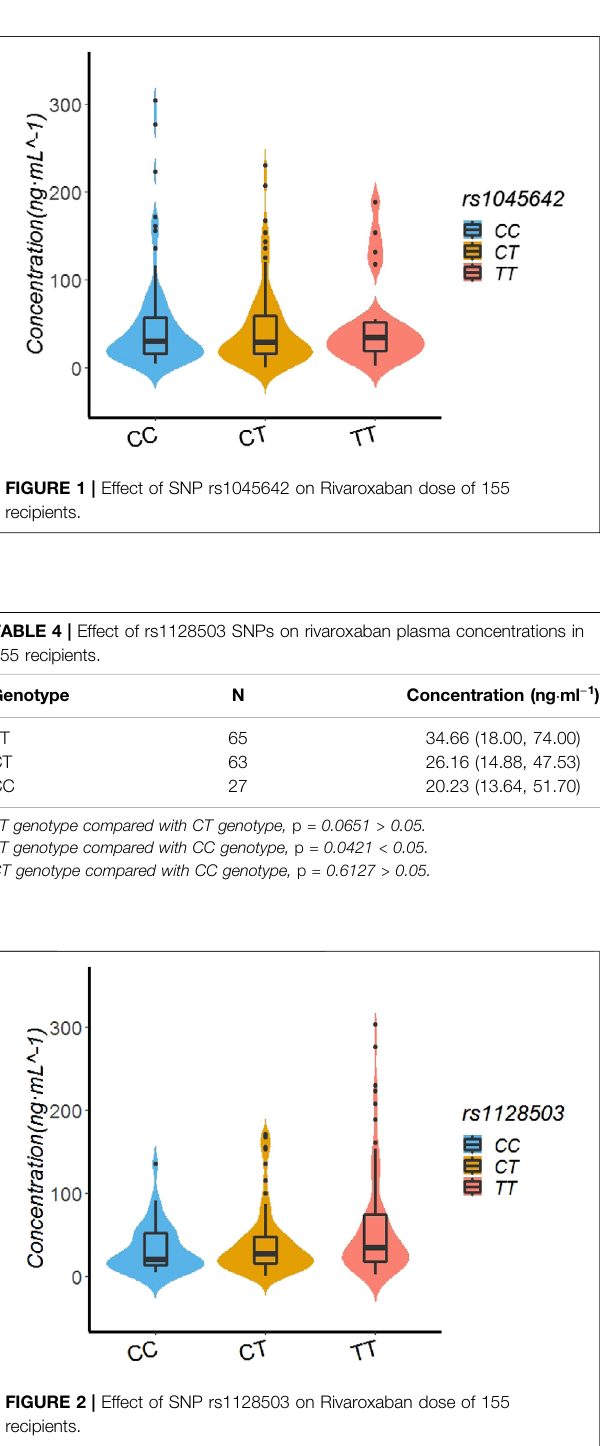
(CT) genotypes at the rs1128503 locus showed no signi fi cant differences of rivaroxaban concentrations ( p (cid:1) 0.0651). Multiple comparisons between mutant CT and mutant CC genotypes at the rs1128503 locus showed no signi fi cant differences of rivaroxaban trough concentrations ( p (cid:1) 0.6127). See Table 4 ; Figure 2 .